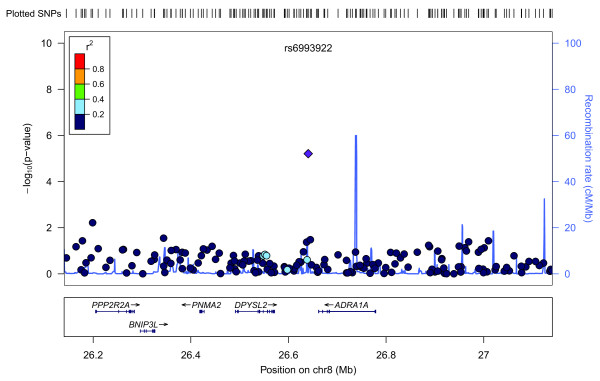
Plot of regional association signals for rs6993922 forwarded for validation.